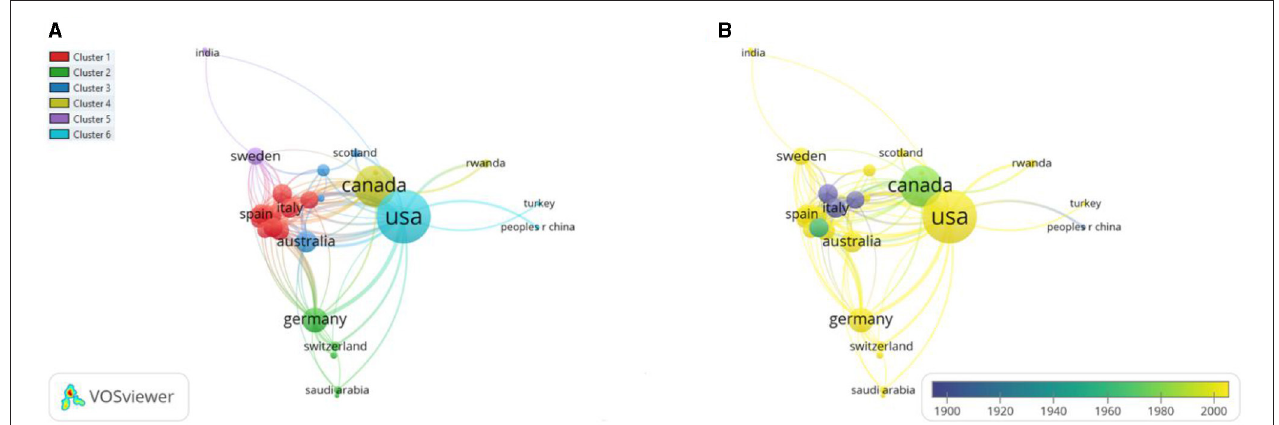
FIGURE 8 | Co-authorship countries (A) Network visualization. (B) Overlay visualization by time